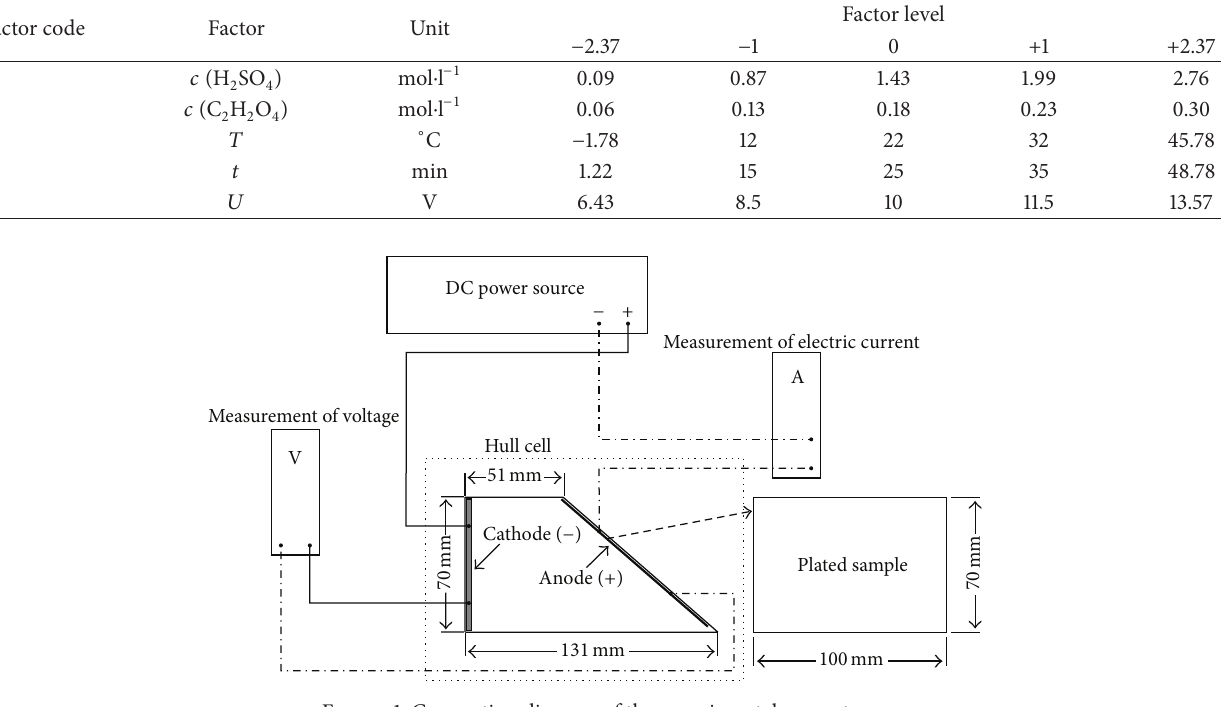
Figure 1: Connection diagram of the experimental apparatus.